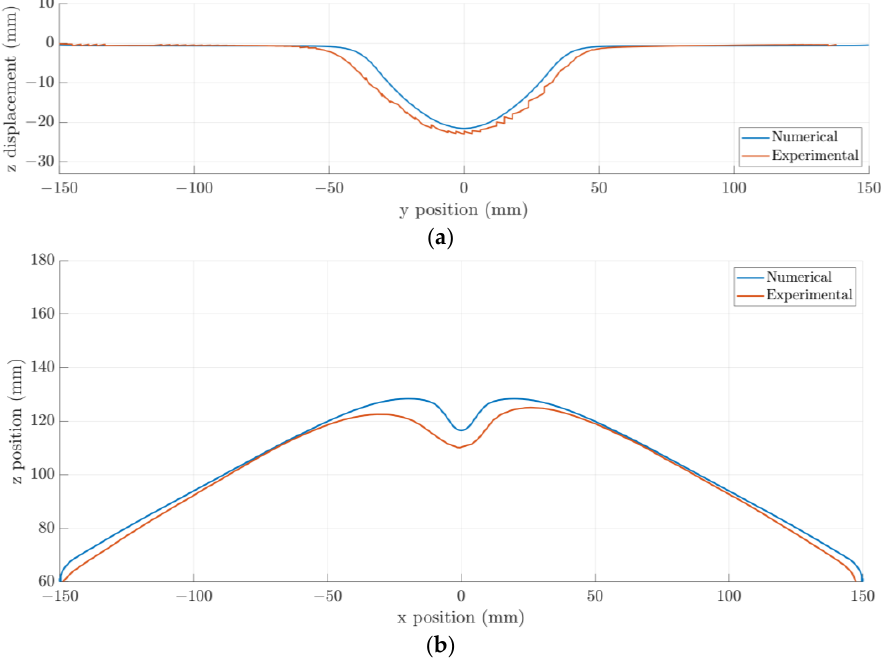
Figure 20. Final deformed profiles for V-structures subjected to blast, comparing experimental re- sults with computational simulations: ( a ) 105° V, 32 mm tip radius, 15 g detonation, ridge profile; with computational simulations: ( a ) 105 ◦ V, 32 mm tip radius, 15 g detonation, ridge profile; ( b ) 120 ◦ V, ( b ) 120° V, 32 mm tip radius, 20 g detonation, cross-cut profile. 32 mm tip radius, 20 g detonation, cross-cut profile.